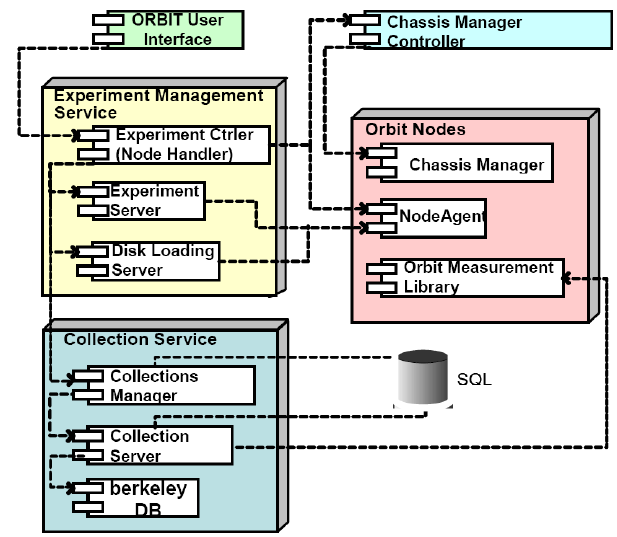
Figure 15. Software architecture of ORBIT